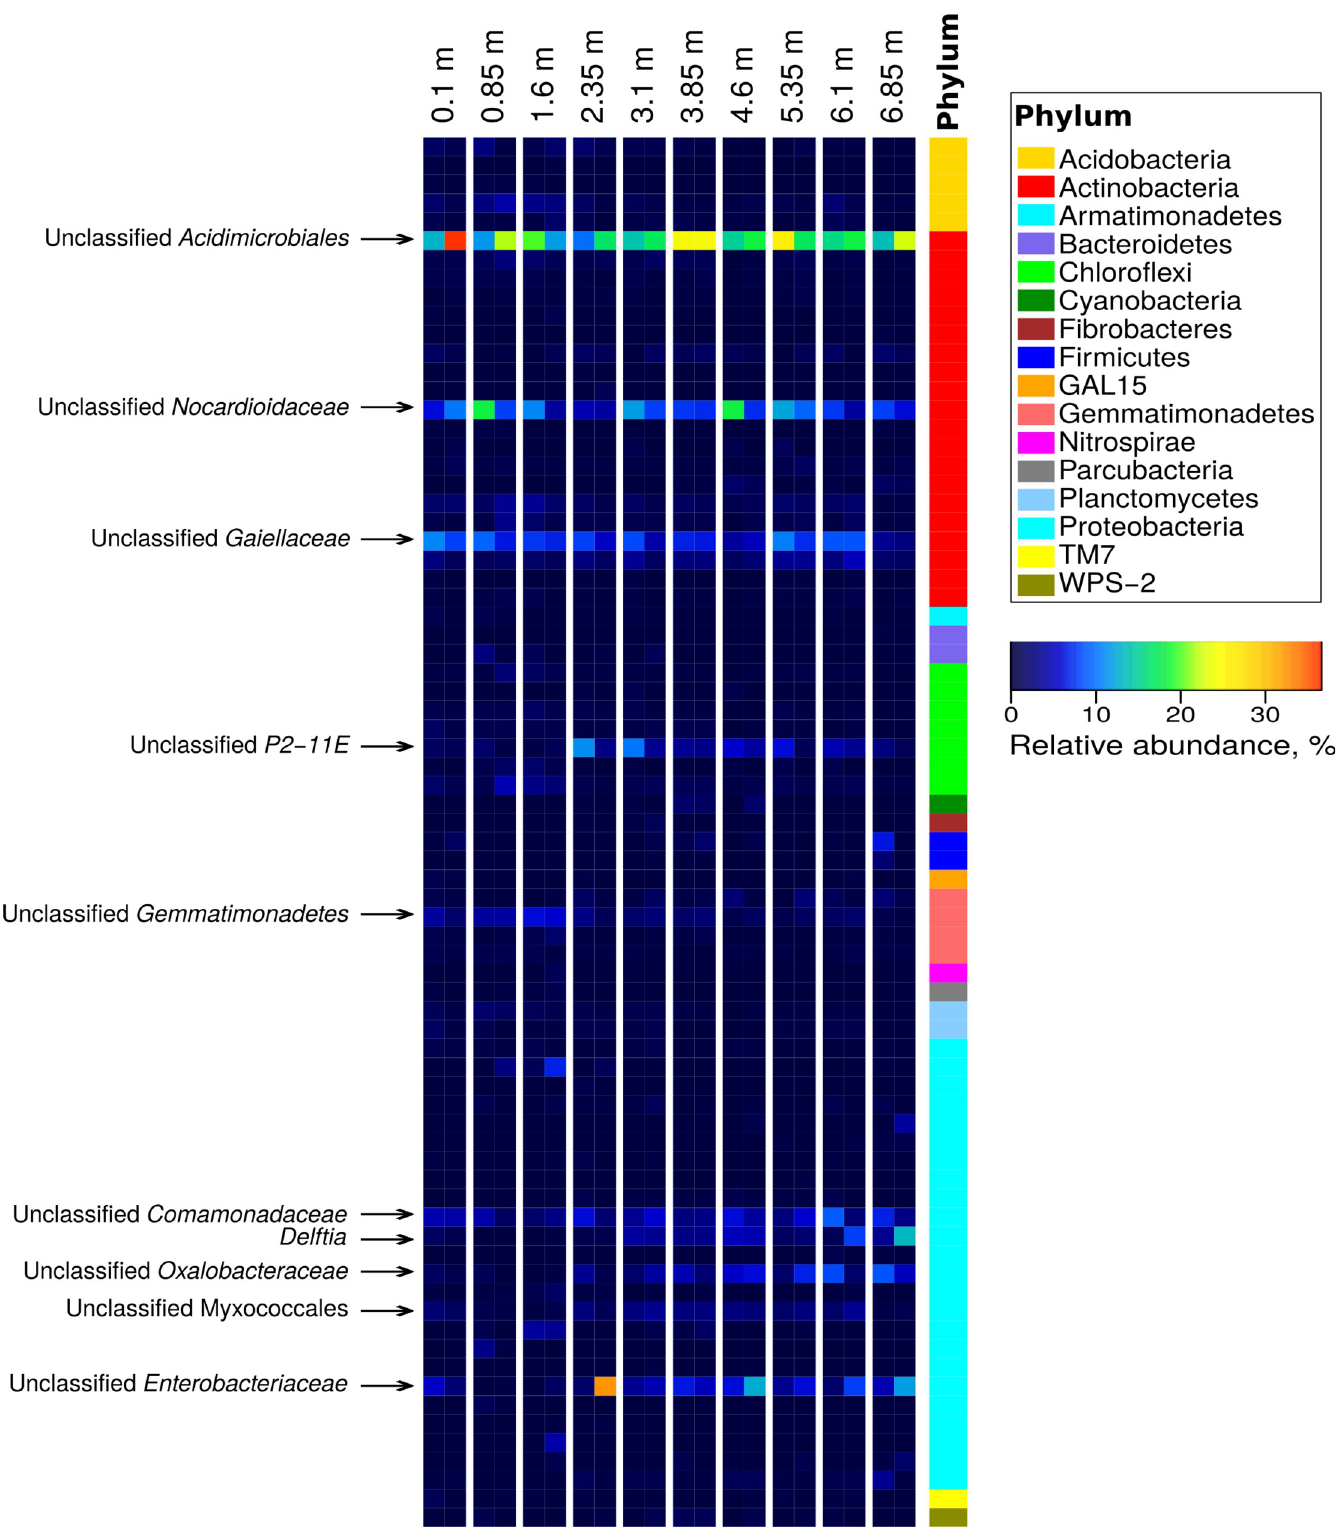
Fig 3. A heat map of the bacterial genera found in serpentine rock core samples collected at different depths. Colors indicate percent relative abundance of 74 genus level taxonomic groupings (i.e. 97% OTU sequence identity) that occur within the major phyla (each representing � 0.5% of all OTUs) detected at different depths. Names of the most highly represented genera are